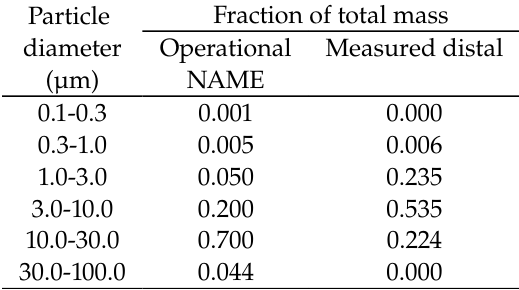
Table1: Volcanic ash PSD used operationally in NAME and distal PSD based on Table 1 from Dacre et al. [2013], derived from FAAM observations on 14 May